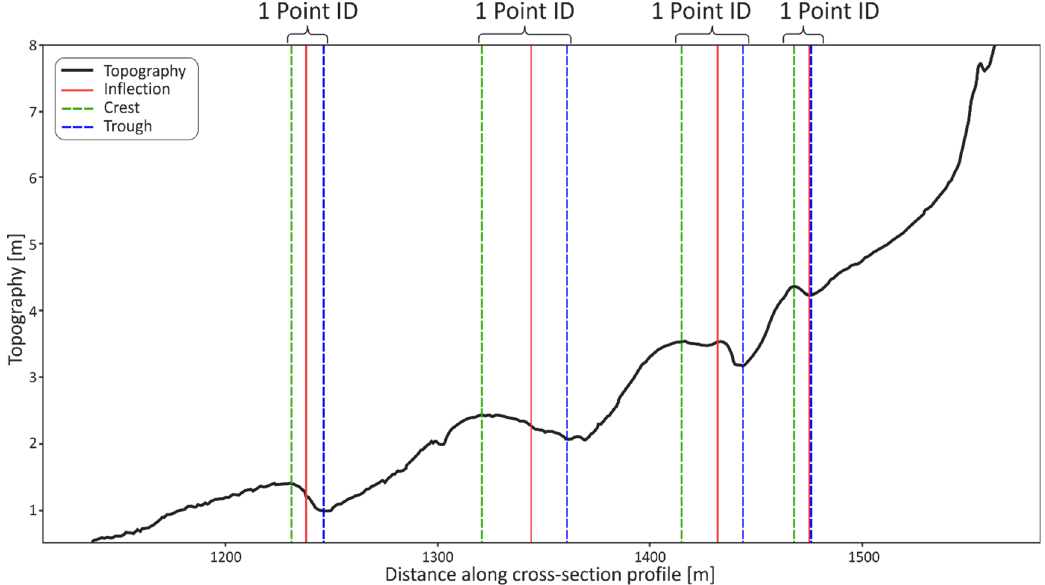
Figure 3. Example of inflection points (red), crest points (green) and trough points (blue) along a cross-shore profile extracted from the LiDAR dataset (Moelans et al., 2021 modified).